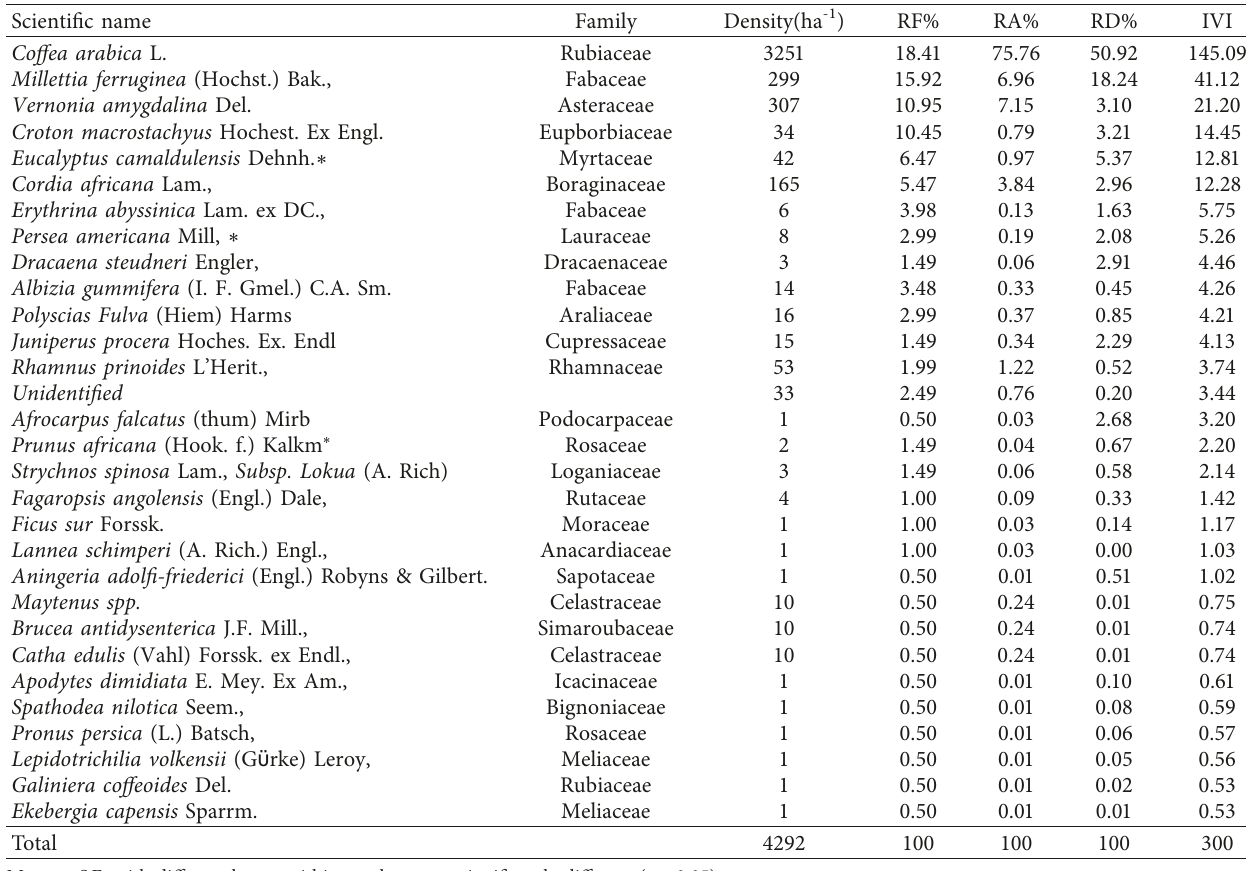
Table 4: Mean value of woody species density, RF, RA, RD, and IVI along an elevation gradient of coffee-based agroforestry system. Scientific name